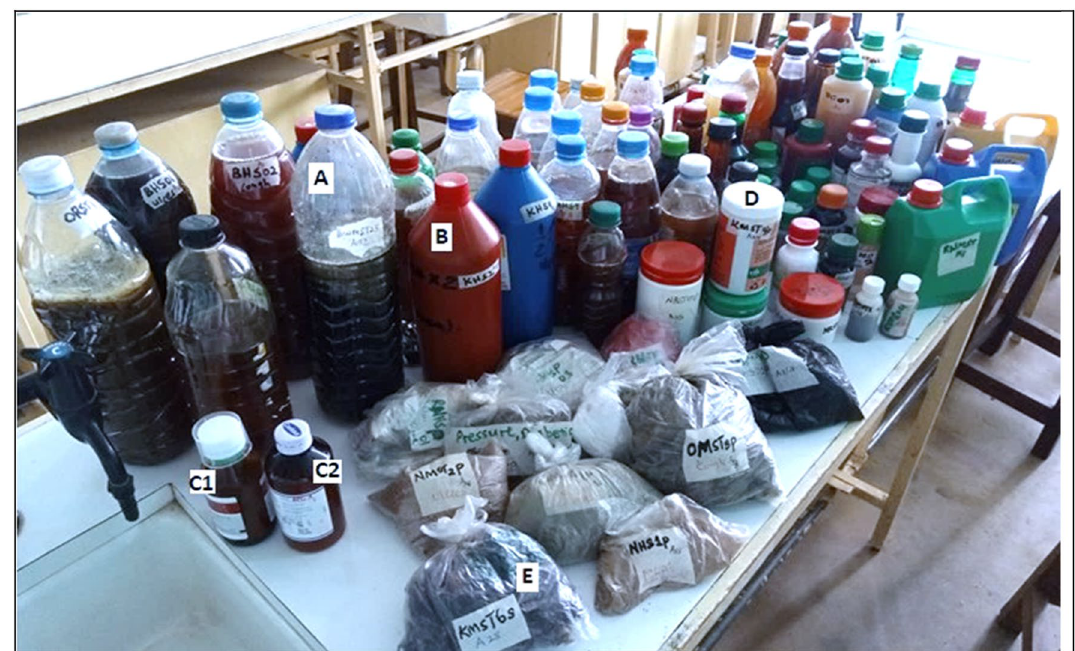
Figure 1. Some of the herbal medicine samples from which contaminant bacteria were isolated. The samples included both solids and liquids.